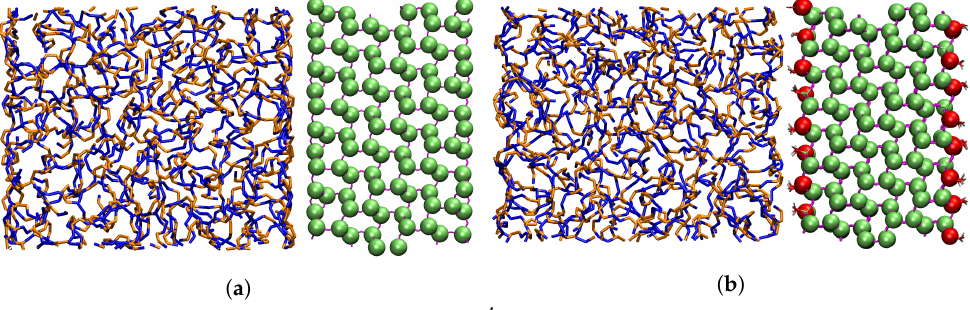
Figure 1. ( a ) Superposition of the AA and CG Q 4 silica wall in front of the polymer. AA silica is represented by lines partially covered by CG Q 4 beads represented as green spheres. ( b ) Superposition of the AA and CG Q 3 silica surface in front of the polymer. CG Q 4 beads are represented as green spheres and CG Q 3 beads as red